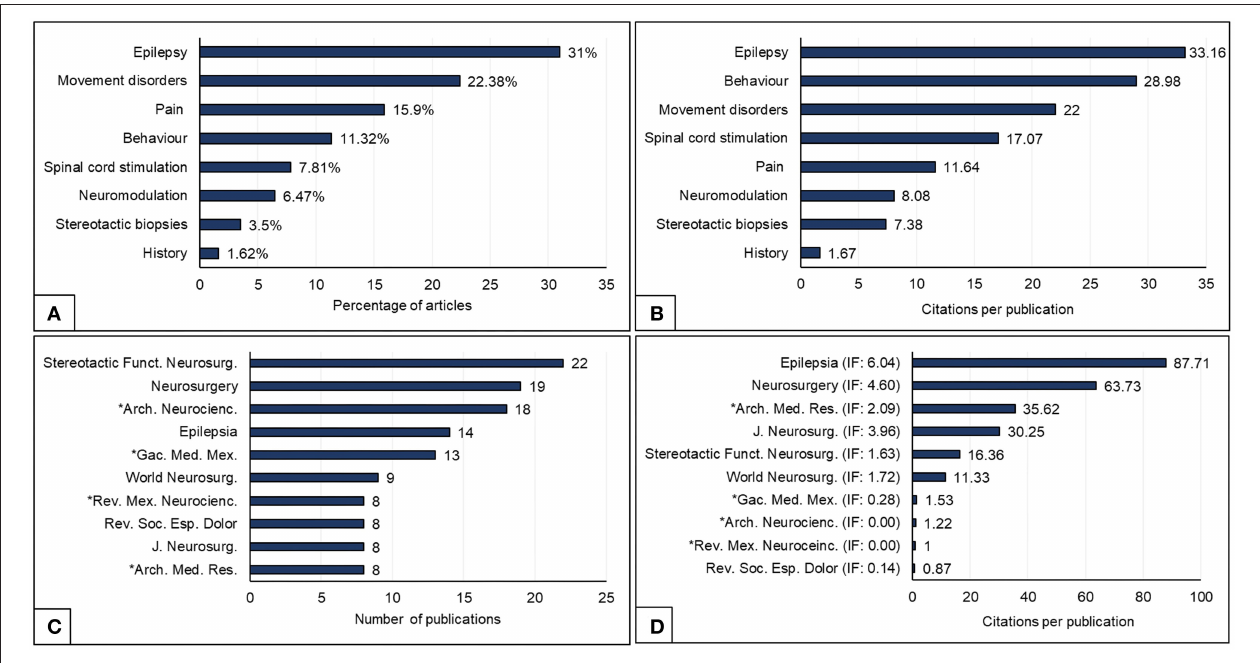
FIGURE 3 | (A) Most frequent topic of publication. (B) Average number of citations per publication (divided by topic). (C) Most frequent journal of publication. (D) Number of citations per journal of publication. Asterisks represent the Mexican